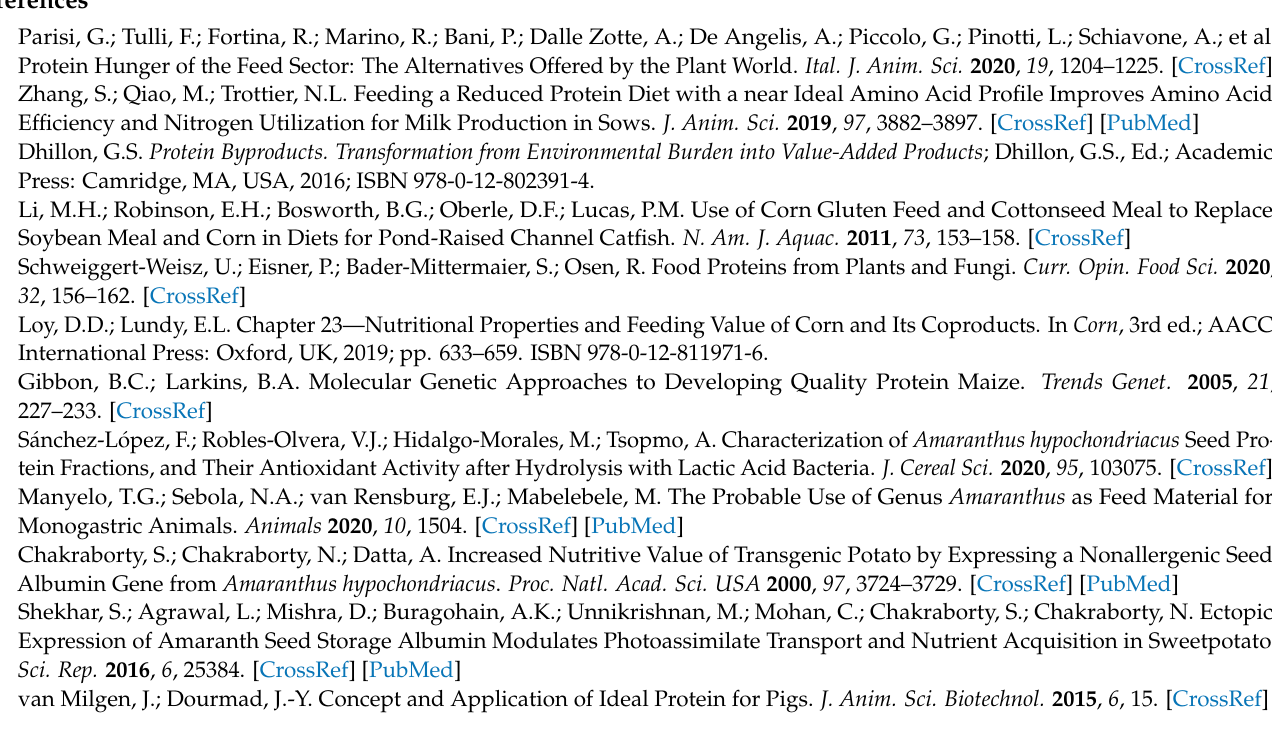
Figure S3: HPLC chromatogram (LC-20 Prominence, Shimadzu, Japan) for determination of Met and Cys; Figure S4: HPLC chromatogram (LC-20 Prominence, Shimadzu, Japan) for determination of Asp, Glu, o-Pro, Ser, Gly, His, Arg, Thr, Ala, Pro, Tyr, Val, Ile, Leu, Phe, Trp, Lys; Figure S5. HPLC chromatogram (LC-20 Prominence, Shimadzu, Japan) for determination of Trp, and Supplementary Materials and Methods